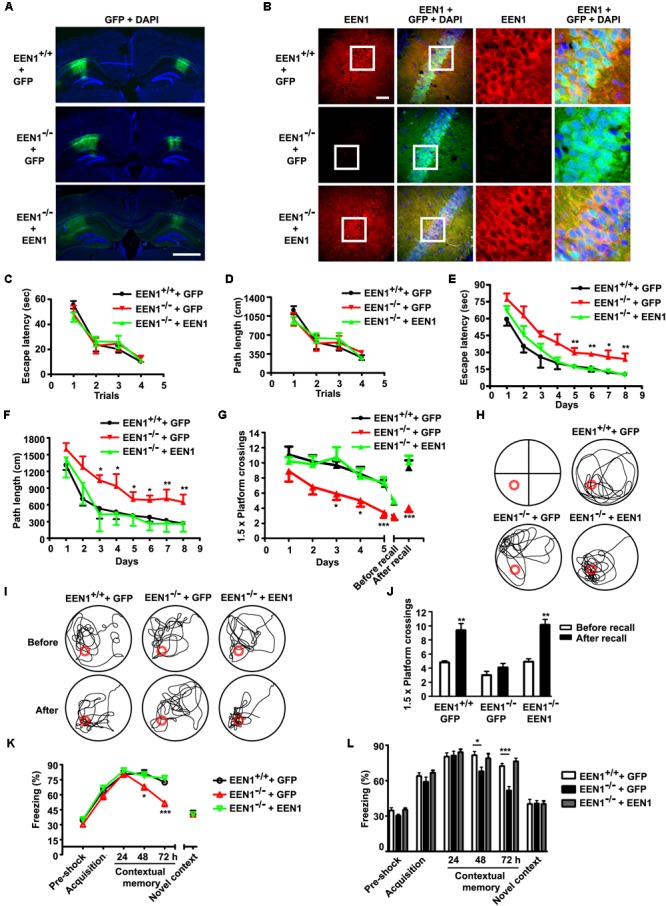
EEN1 overexpression in hippocampal CA1 of adult KO mice restores long-term spatial and contextual fear memory. (A) AAV virus was stereotaxically injected into the CA1 regions of EEN1-/- mice to express GFP alone or EEN1 and GFP. Shown are confocal images of GFP signal and DAPI labeling of nuclei 21 days after viral injection. Scale bar, 1 mm. (B) Immunofluorescence staining of EEN1 in CA1 neurons of brain slices 21 days after injection of AAV virus into the CA1 region of EEN1-/- mice. Right panels are magnification of the boxed areas. Scale bar, 100 μm. (C–J) The Morris water maze test. Shown are escape latency or traveled distance before escaping to the platform in the visible-platform training (C and D), escape latency and traveled distance before escaping to the platform in the invisible-platform training (E and F), number of crossing with the 1.5× platform area and the swim trace 5 days after training in probe test (G and H), the swim trace and recall ability following training once again 1 month after training (I and J). Data represent mean ± SEM (11 EEN1+/+ + GFP, 10 EEN1-/- + GFP, 14 EEN1-/- + EEN1), ∗p < 0.05, ∗∗p < 0.01, ∗∗∗p < 0.001. (K and L) Restoration of freezing behavior in EEN1-overexpressed EEN1-/- mice, compared with control mice. Data represent mean ± SEM (11 EEN1+/+ + GFP, 10 EEN1-/- + GFP, 14 EEN1-/- + EEN1), ∗p < 0.05, ∗∗∗p < 0.001.